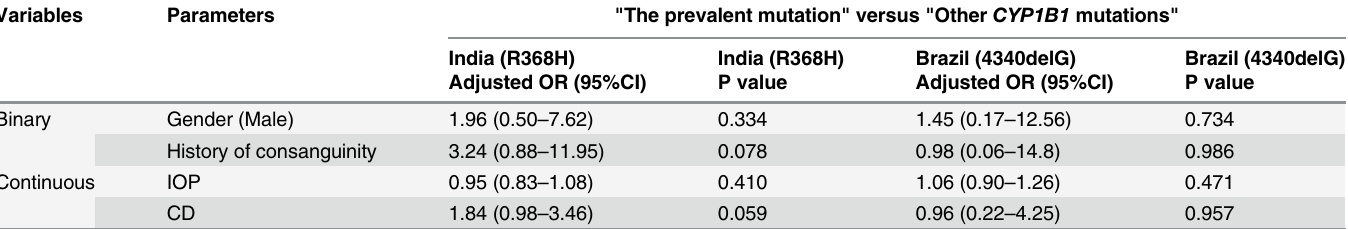
Table 5. Logistic regression showing the adjusted odds ratios for the binary and continuous variables with the prevalent CYP1B1 mutation in the Indian and Brazilian